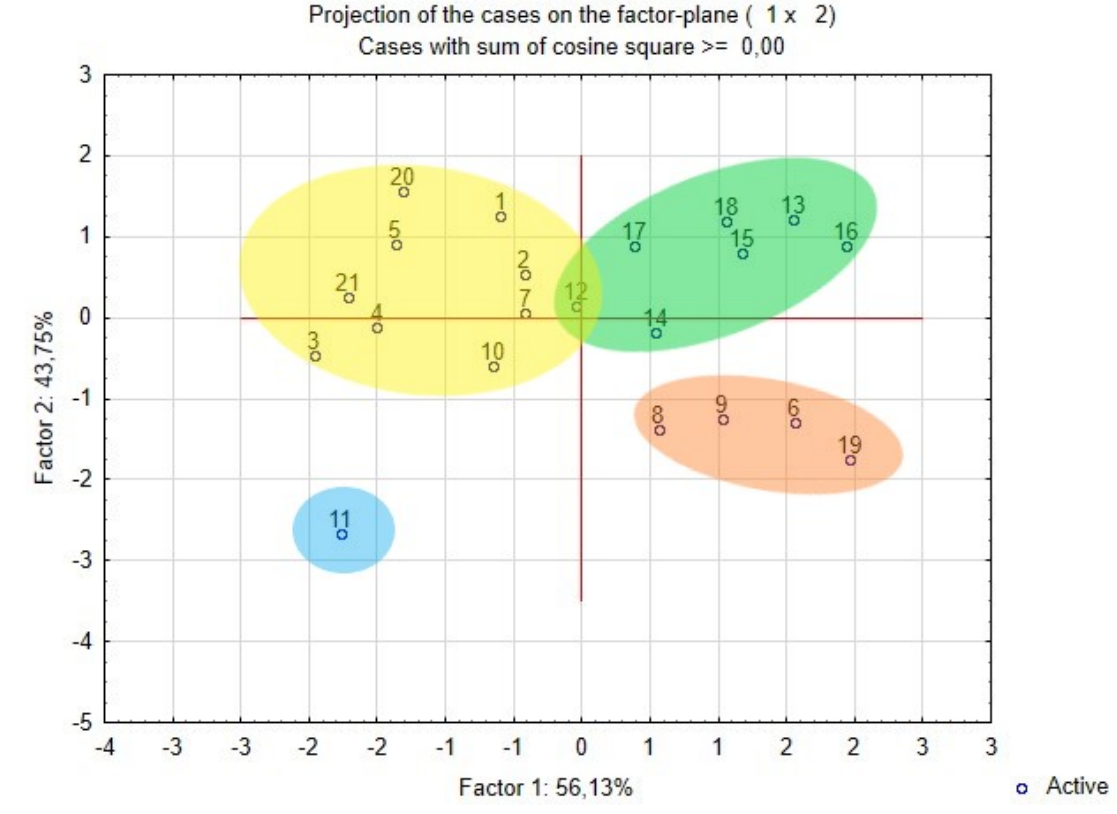
Figure 4. The PCA plot showing four clusters of Nitraria specimens. Blue ellipse: N. komarovii ; green ellipse: N. schoberi ; orange ellipse: N. pamirica (specimen No. 19) and specimens of N. sibirica (Basshi, Taskarasu, and Karatal); yellow ellipse: N. tangutorum , N. praevisa , and specimens of N. sibirica (Balhash, Kosh ‐ Agach, Dauria, Shelek, Balansor, Kurti, and Koktal).